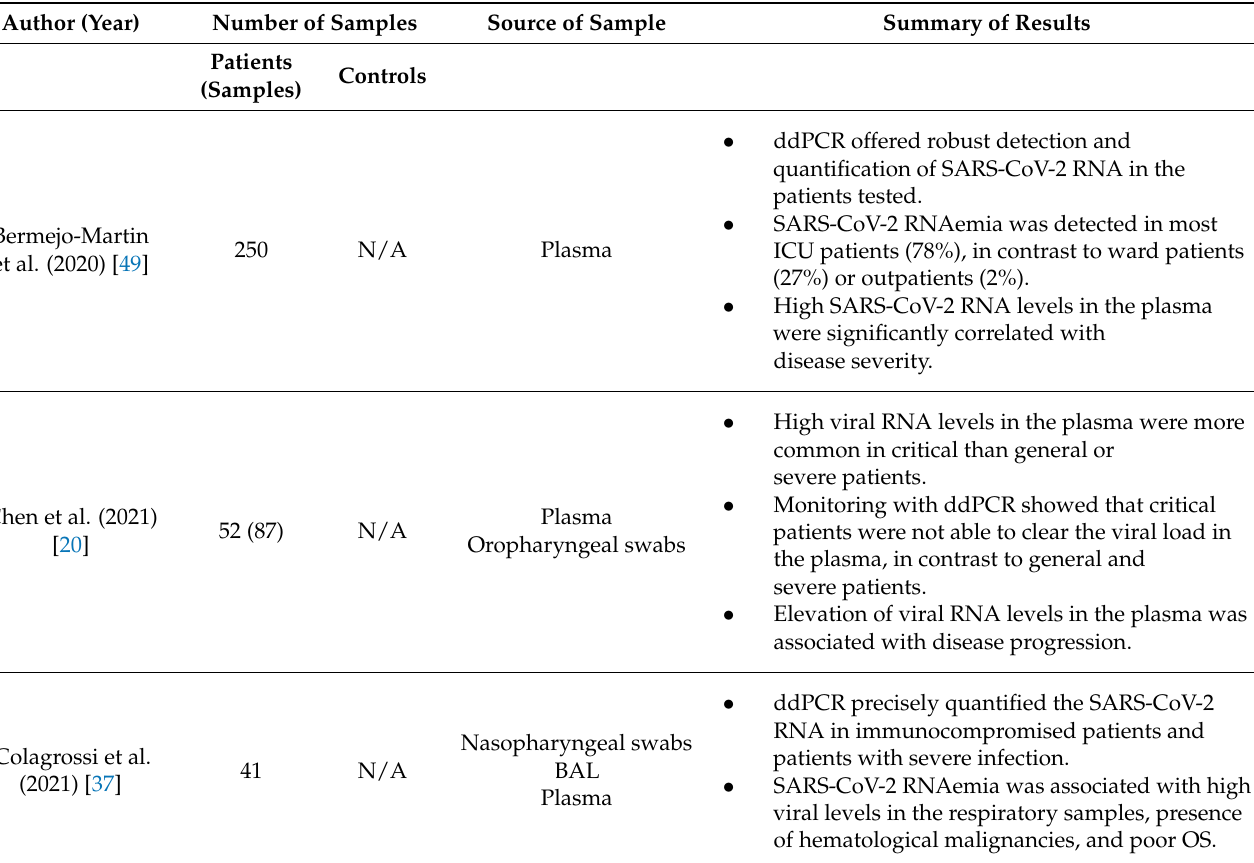
Table 2. Prognostic and therapeutic value of droplet digital PCR (ddPCR) in COVID-19